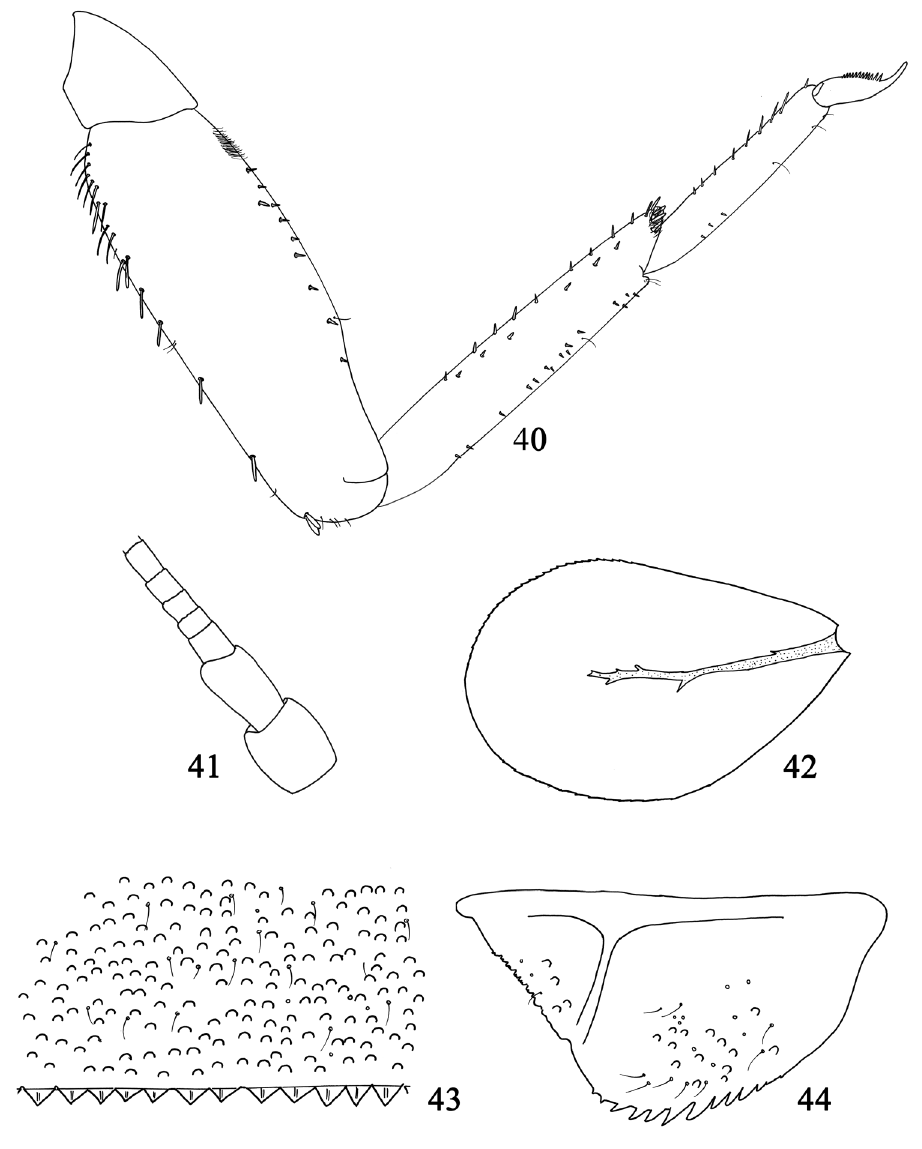
Left mandible (Fig. 36): canine with two almost fused incisivi each with four den- ticles, outer denticle much shorter than others; stout prostheca apically with small denticles and a comb-shaped structure; margin between prostheca and mola straight, distally with crenulations; tuft of setae at apex of mola reduced to a single